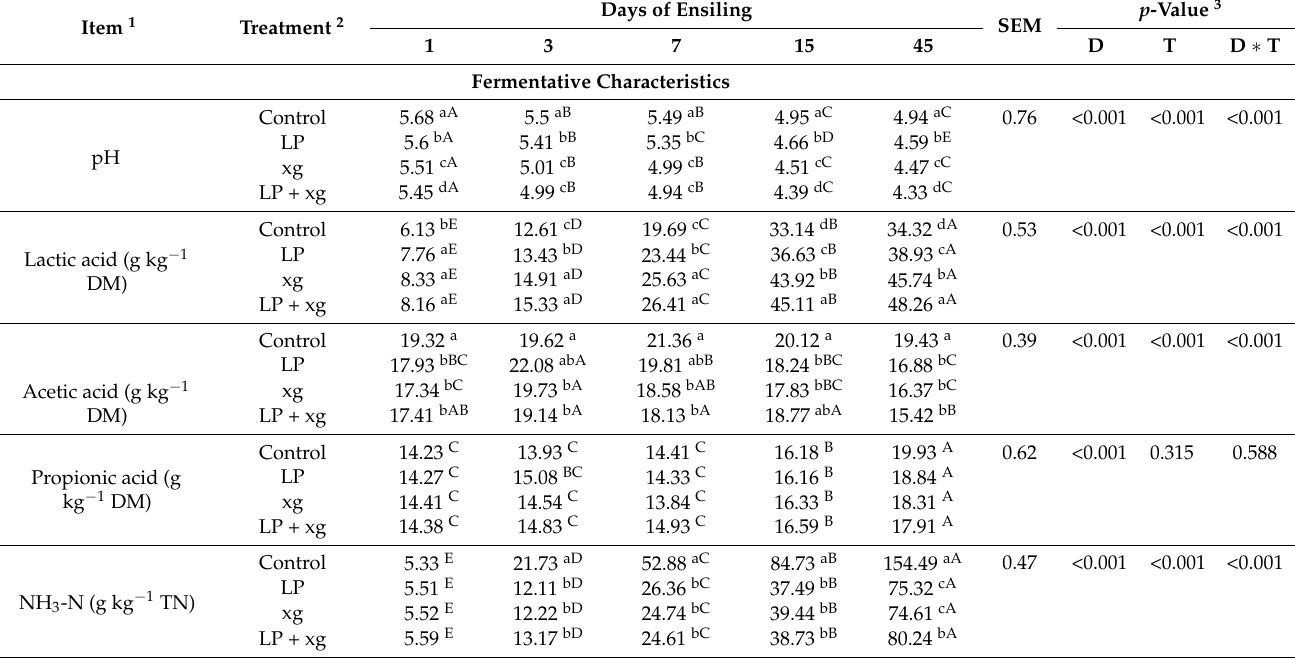
Table 1. Changes in fermentative characteristics during the ensiling of high-moisture content Sty- losanthes